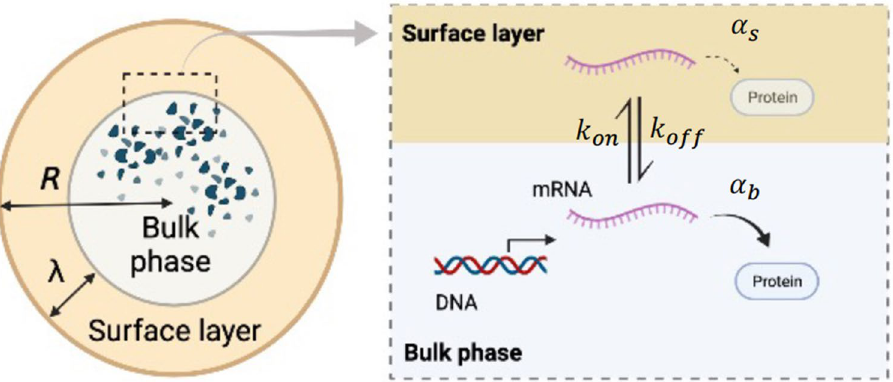
Figure 1. Schematic illustration of the TXTL reaction. Gene expression is modeled considering the excluded volume effect in a cell-sized spherical compartment. In the bulk phase (yellow), the transcription at the reaction rate α r and the translation at the reaction rate α b proceed. On the other hand, in the surface layer (orange) transcription is completely suppressed. Furthermore, mRNA binds to boundary surface from the bulk phase and, in turn, the translation rate drops to α s in the surface layer. Figure was created with